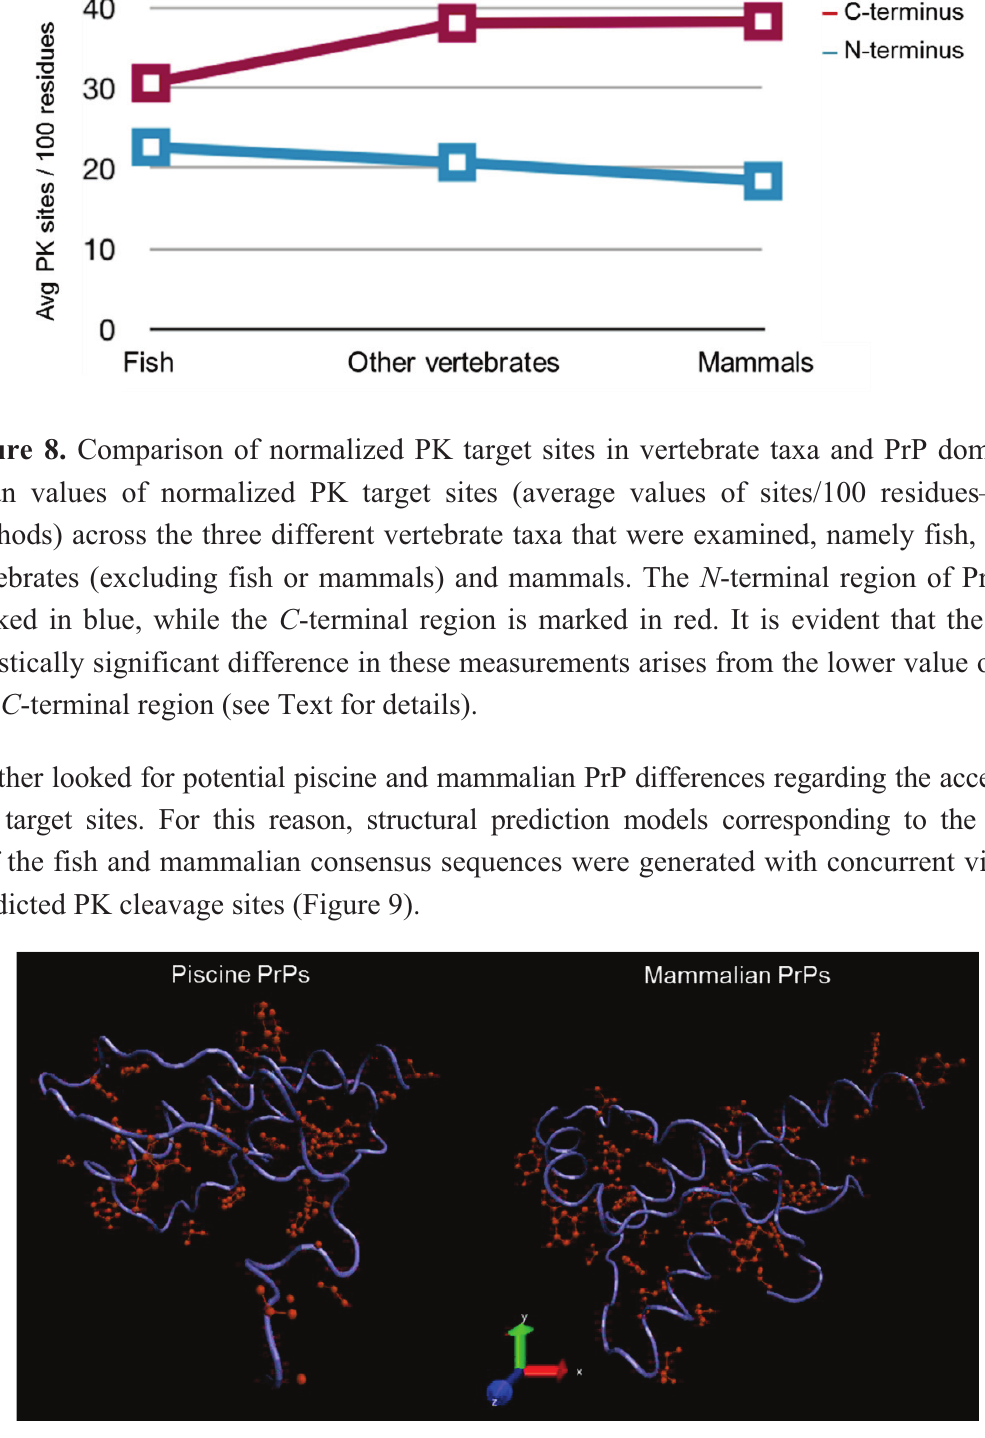
Figure 9. Fish (left) and mammalian (right) models of PrP C -terminal domain shown as ribbon trace, with putative PK sites highlighted with side chains (in red). Details